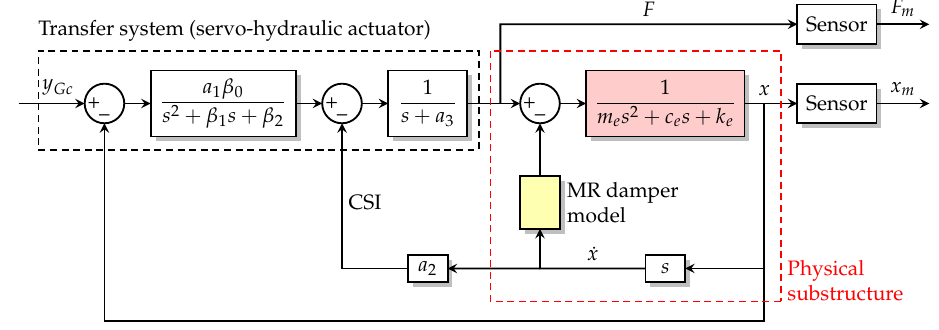
Figure 10. Block diagram of the physical plant for Intact w/ d.